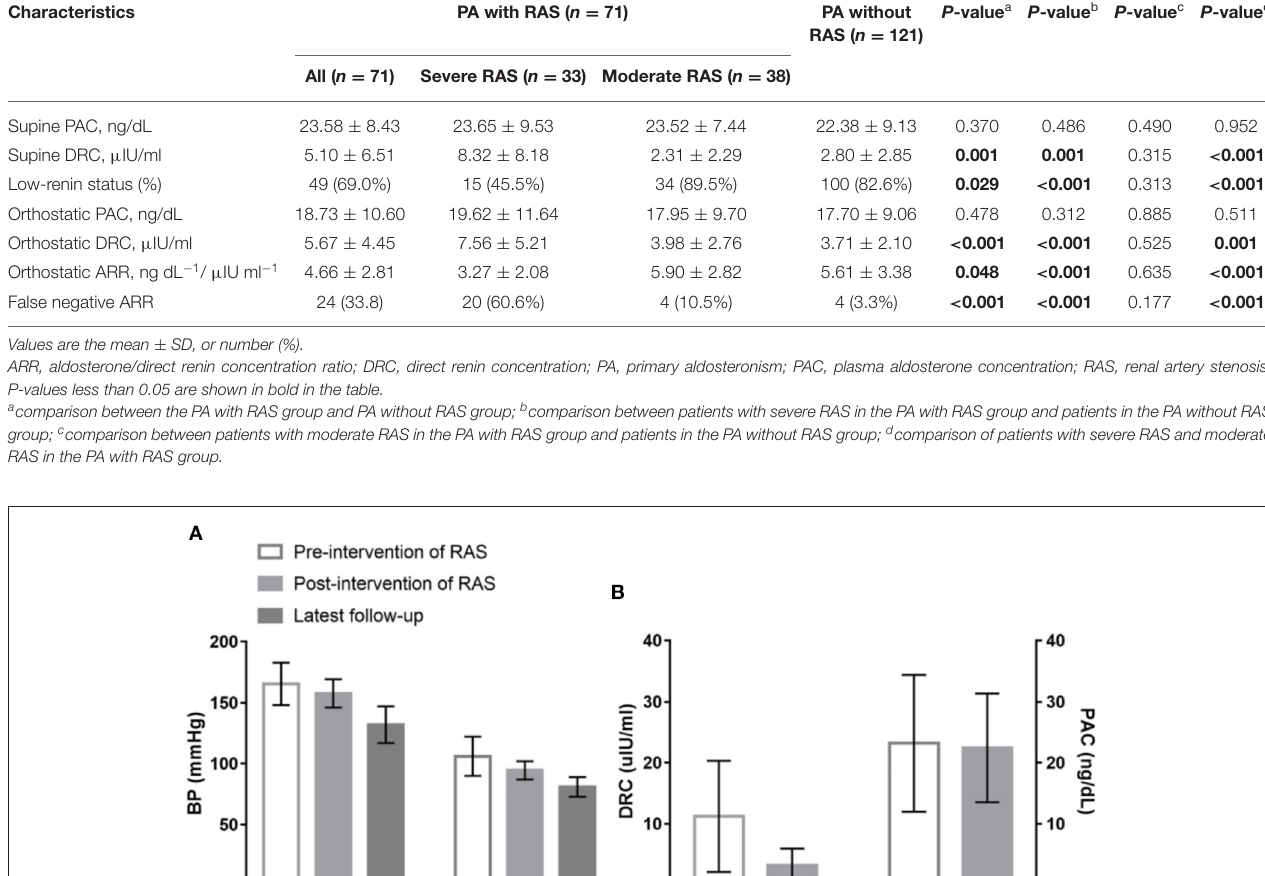
TABLE 2 | Results of PA screening tests among subjects in the PA with RAS group and PA without RAS group at baseline. Characteristics